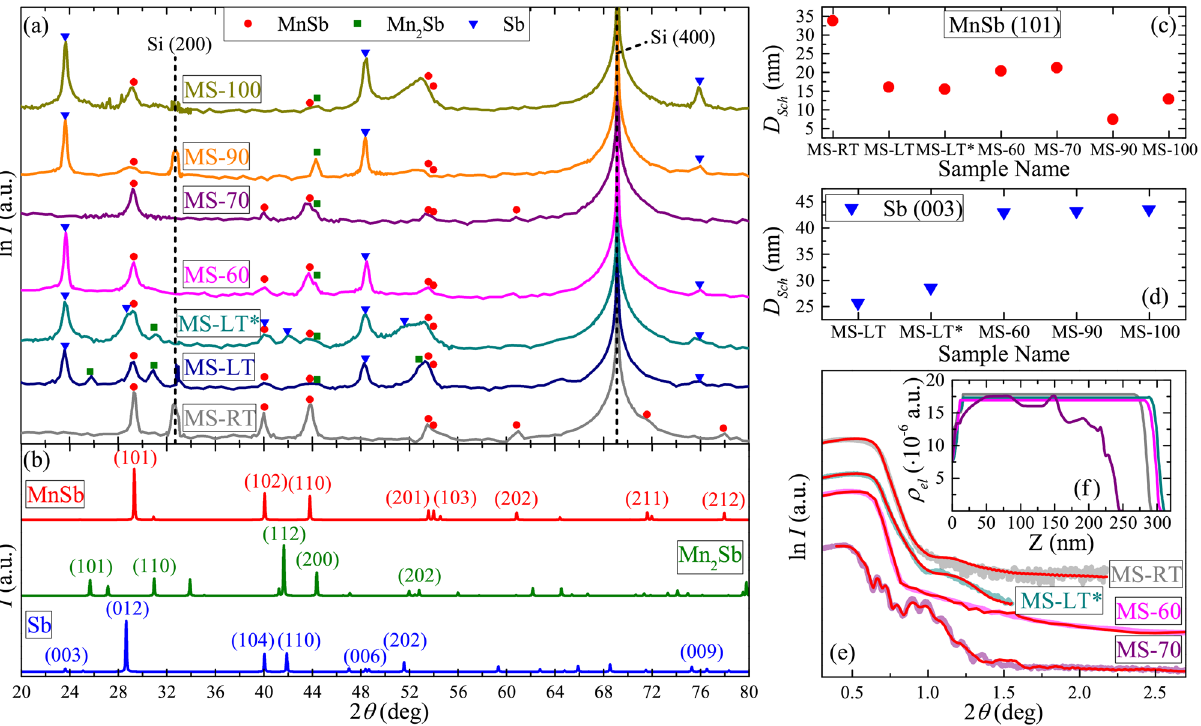
Figure 1. ( a ) Experimental X-ray diffraction patterns of studied films in logarithmic scale, curves are vertically shifted for clarity. Symbols in this panel correspond to the peak positions of reference powder XRD patterns for pure MnSb (PDF-2 01-072-5844), Mn 2 Sb (PDF-2 01-089-4962) and Sb (PDF-2 01-085-1322). Corresponding patterns with marked hkl indices of considered reflections are given in panel ( b ), in linear scale. Mean crystallite size for studied films estimated from ( c ) MnSb (101) and ( d ) Sb (003) reflections using Scherrer equation (1). ( e ) Experimental X-ray reflectivity curves for several studied samples, curves are vertically shifted for clarity. Corresponding fitting curves are shown as red lines. Obtained electron density profiles as a function of distance from the substrate are given in ( f